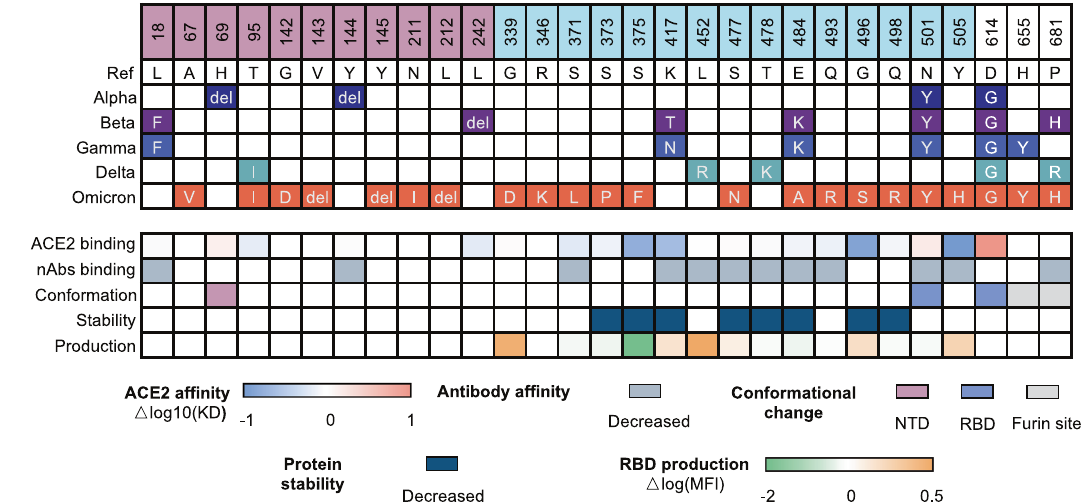
Fig. 3 Heatmap of the mutation site and the mutational impact of SARS-CoV-2 VOCs on the spike protein characteristics. The mutations of VOCs vary from strain to strain and could exert multiple impacts on the protein characteristics of spike protein, including the ACE2 binding, antibody af fi nity, protein conformation, stability, and productivity. Quantitative results were recorded on the in fl uence of ACE2 af fi nity and RBD production, and qualitative results were recorded on antibody af fi nity, conformational change, and protein stability. Details for each mutation can be found in Supplementary Table